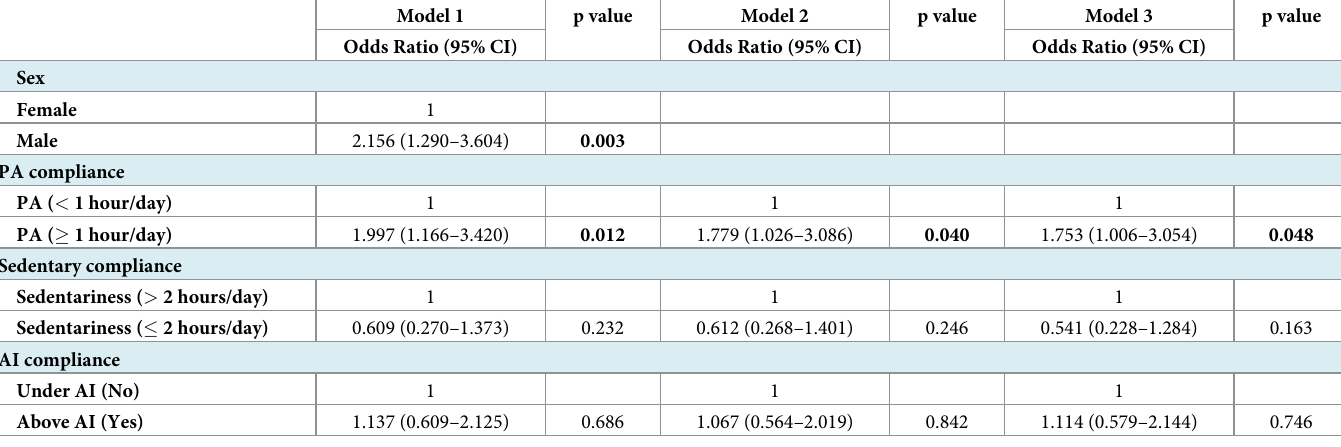
Table 4. Association of sex, lifestyles and compliance with AI water guidelines with the prevalence of